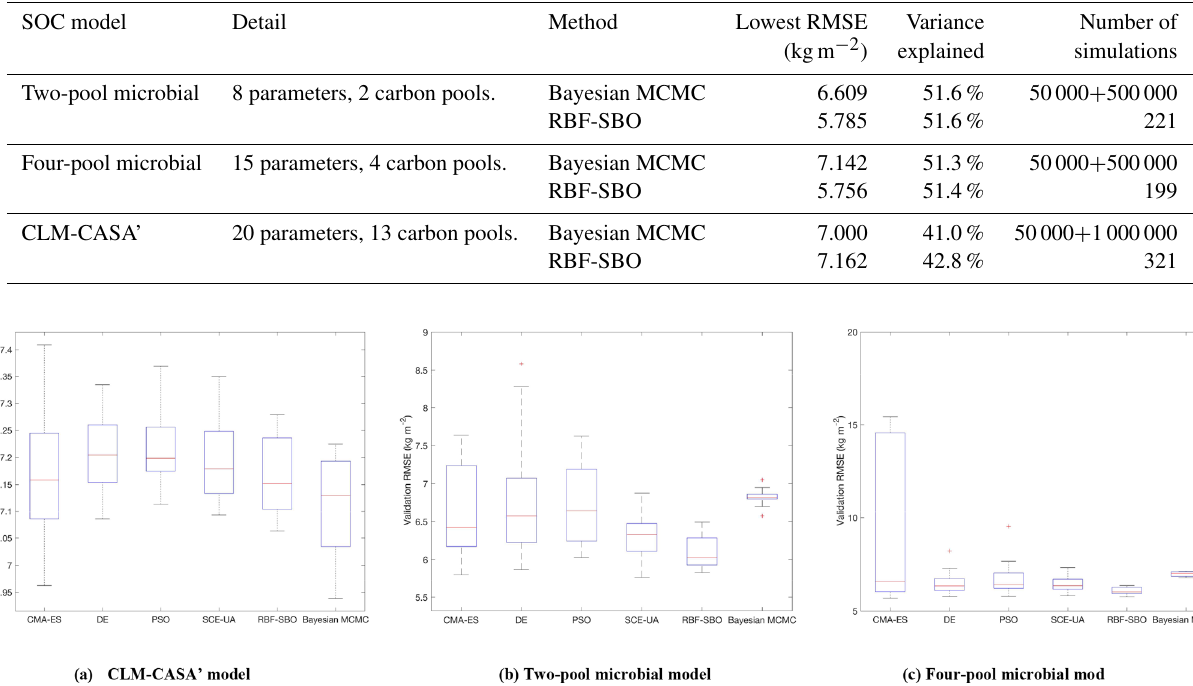
Table 3. Calibration results of the Bayesian MCMC and our surrogate-based optimization.